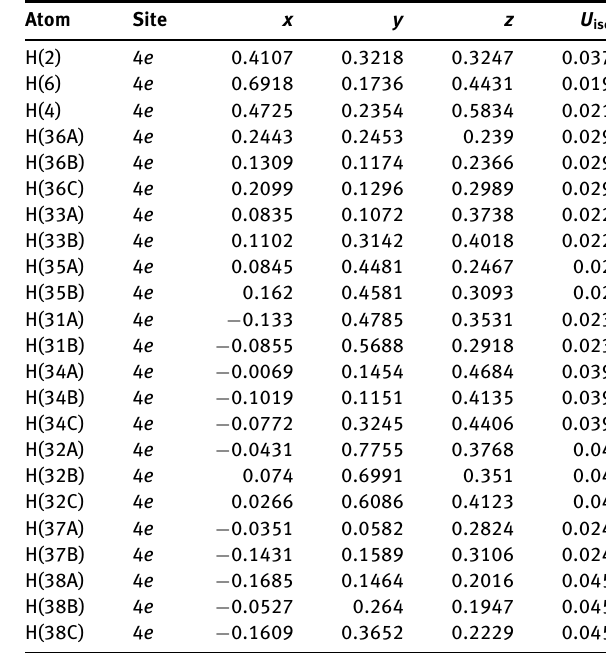
Table 2: Fractional atomic coordinates and isotropic or